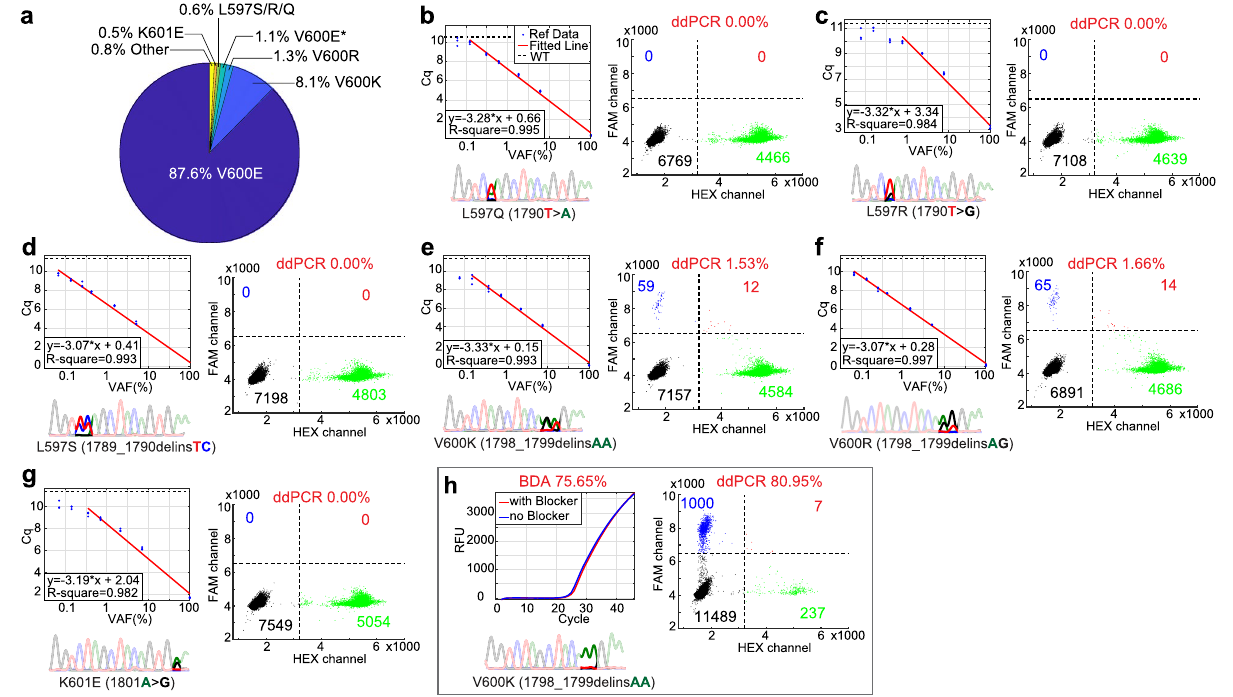
Figure 4. Analytical and clinical testing of non-V600E BRAF mutations. ( a ) BRAF mutation distribution in melanoma. Melanoma-associated BRAF mutation data was retrieved from the COSMIC database 31 and mutations with total counts greater than 10 were collected and plotted. Non-V600E mutations make up more than 10%. ( b – g ) Characterization of BDA Sanger performance on non-V600E BRAF mutations. Figures show qPCR Cq calibration, Sanger sequencing of low abundance reference material and ddPCR results for L597R, L597Q, L597S, V600K, V600R and K601E mutations. Triplicate qPCR data points were plotted as individual blue dots. The Cq values and logarithmic VAF values of reference samples were used to generate fitted red line. Cq values for WT samples were shown as dashed black line. Sanger traces are shown for 0.5% VAF spike-in reference samples. ddPCR plots are shown for 2% VAF spike-in samples; ddPCR was unable to make mutation calls for non-V600 mutations, as expected. ( h ) Results for non-macrodissected patient 7 sample 129538. BDA Sanger reported a V600K mutation whereas ddPCR did not identify the specific